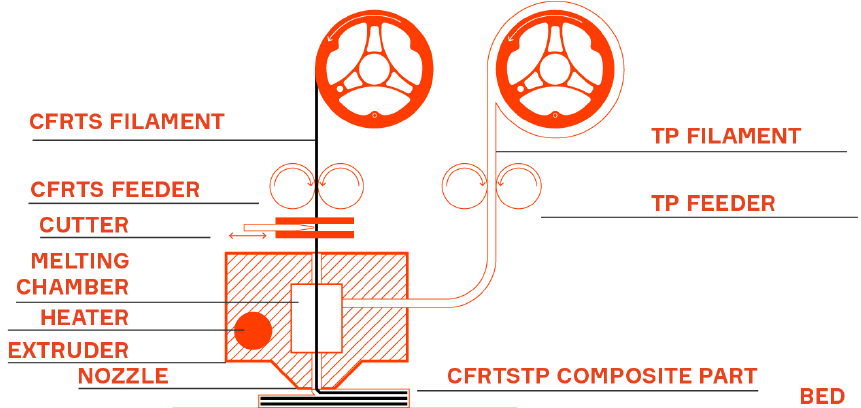
Figure 5. Continuous fiber-reinforced thermoset-thermoplast (CFRTSTP) composite 3-D printer schematic.